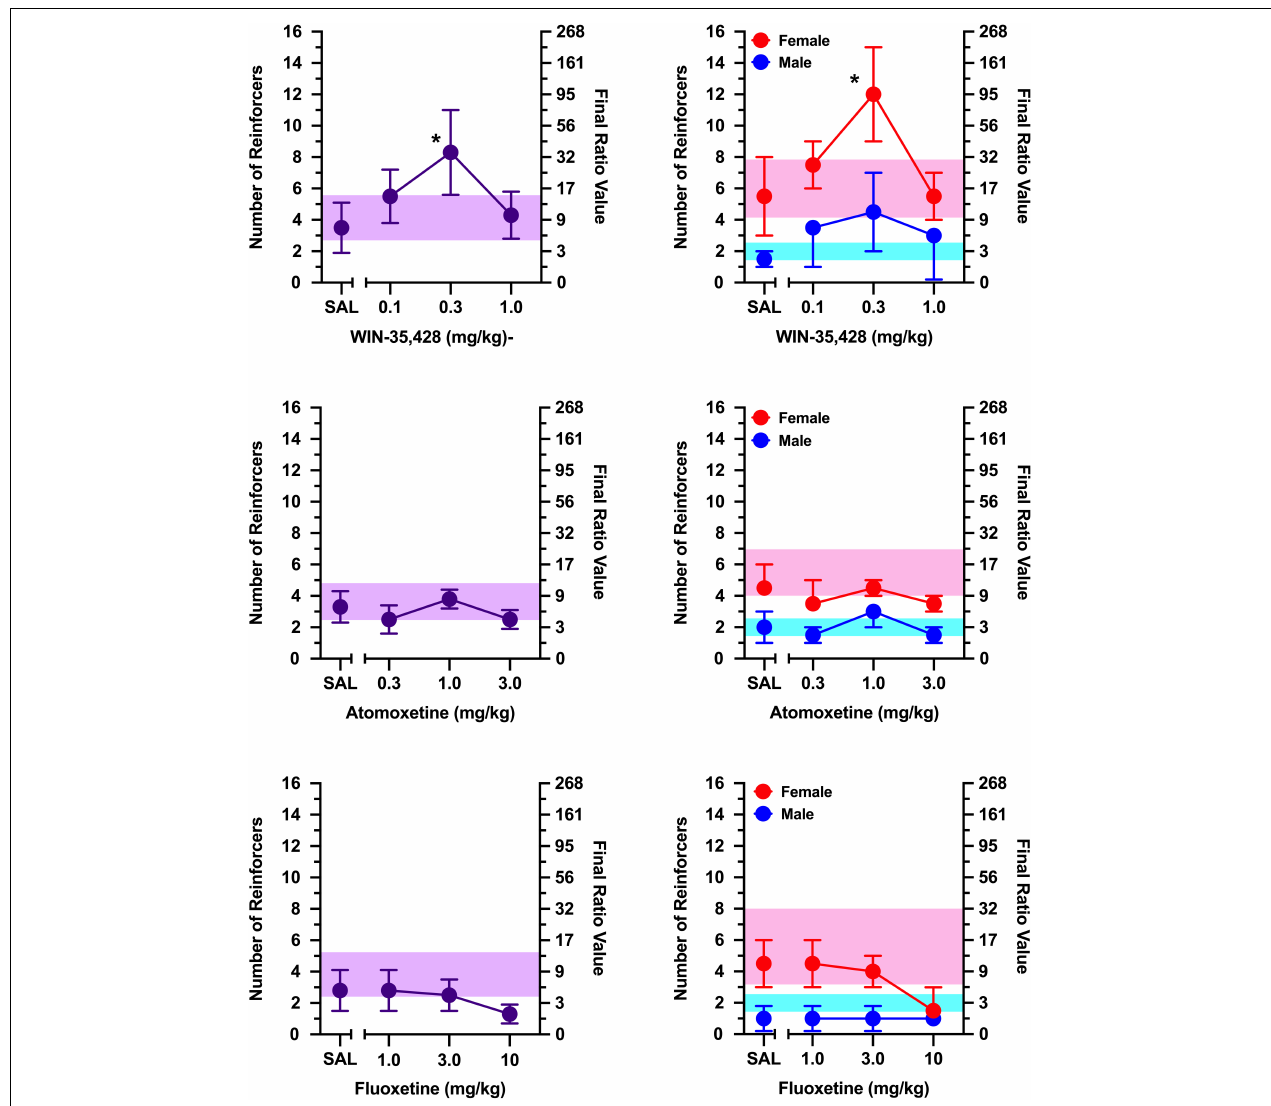
FIGURE 4 | The effects of WIN-35,428 (top) , atomoxetine (middle) , and fluoxetine (bottom) on breakpoints maintained by a non-social stimulus (i.e., black-and-white athletic sock). Left panels depict data collapsed across males and females. Right panels depict data collected in males and females separately. Left axes reflect breakpoint defined as the number of reinforcers obtained; right panels depict breakpoint as final ratio value completed. Bottom axes represent the effects of saline (SAL) and doses of WIN-35,428, atomoxetine, and fluoxetine expressed in mg/kg. Vertical lines extending from data points represent the SEM. Asterisks (*) indicate significant difference relative to saline. Shaded regions indicate variance in breakpoint during non-injection control sessions (purple = collapsed across sex; blue = male; pink =